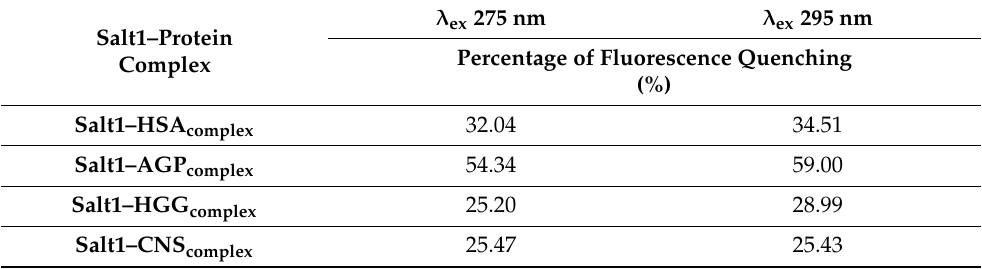
Table 1. Protein fluorescence quenching at λ ex 275nm and λ ex 295 nm.